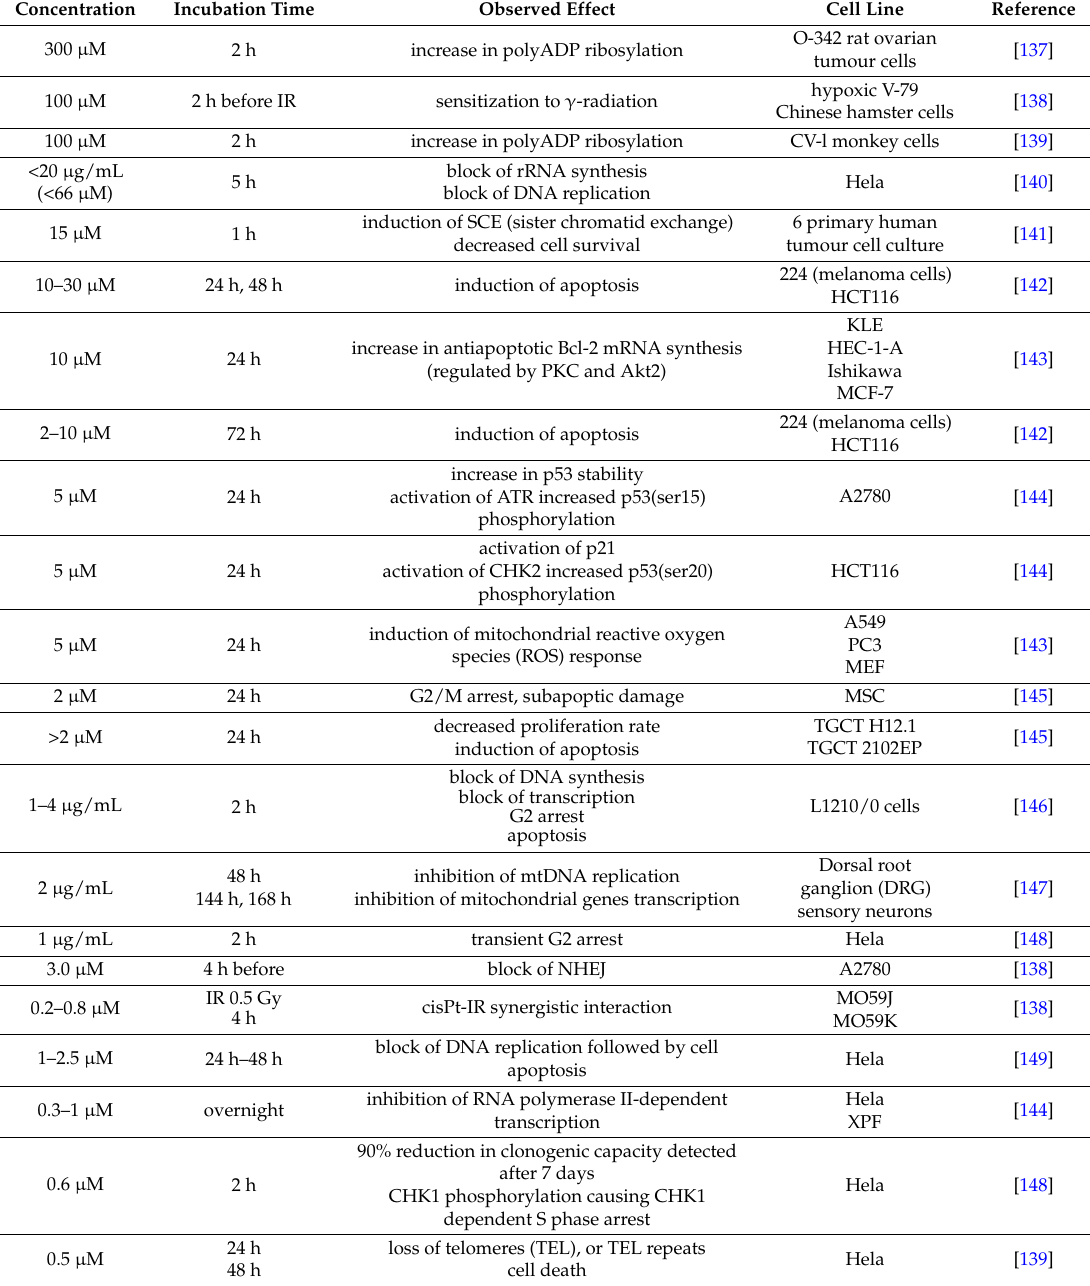
Table 1. Effects of various cisplatin treatments in